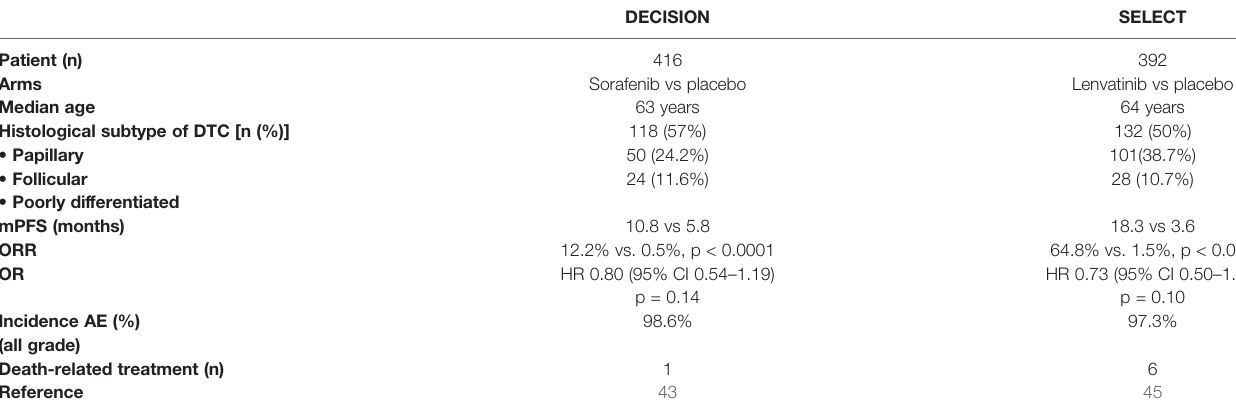
TABLE 4 | Patients main characteristics and results of SELECT and DECISION